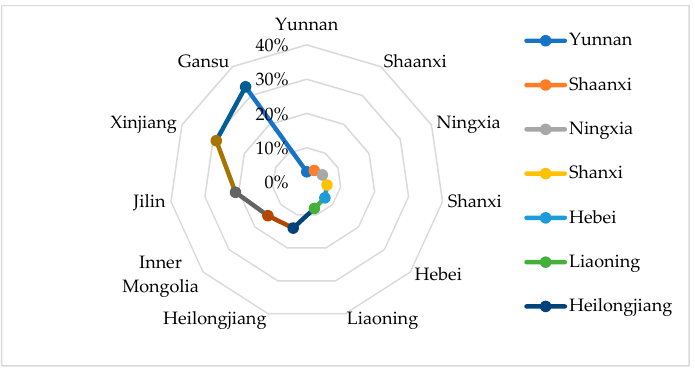
Figure 11. Areas and corresponding rejection rates in 2017. (Data source: [70] and annual wind power development report 2017 in website of NEA).